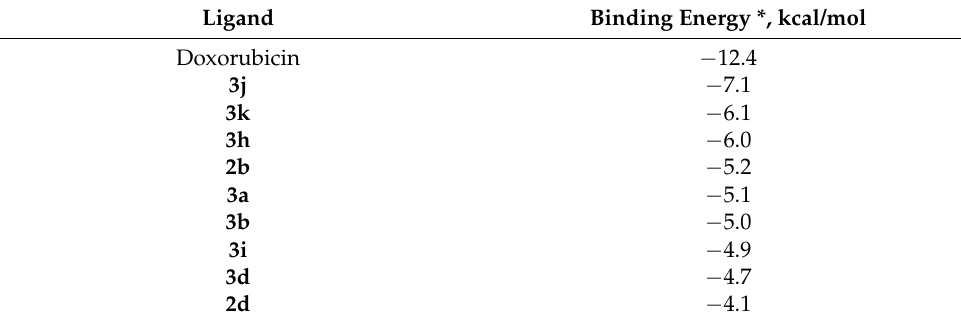
Table 3. DNA docking results for new molecules. Ligand